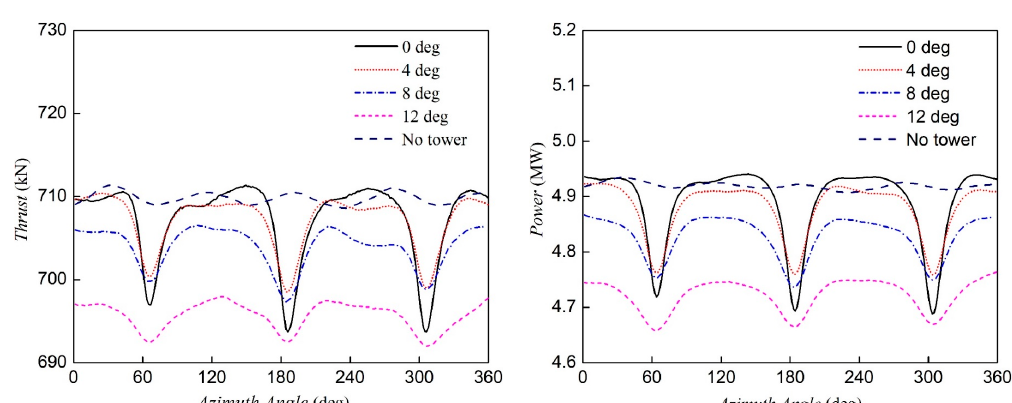
Figure 9. Comparison of thrust and power at different nacelle tilt angles.